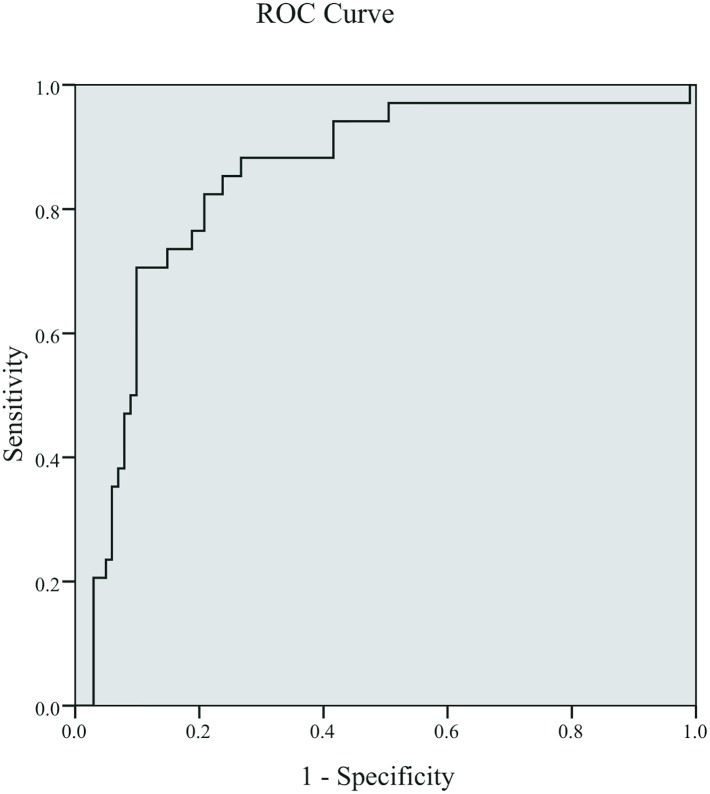
Receiver operating characteristic curves for CSF protein in predicting outcomes (poor, good) in neonates with bacterial meningitis.Sensitivity (true positive rate) is plotted against 1-specificity (false positive rate). The area under the curve was 0.842 for the best cutoff value at 1880 (specificity = 70.8%, sensitivity = 86.2%).